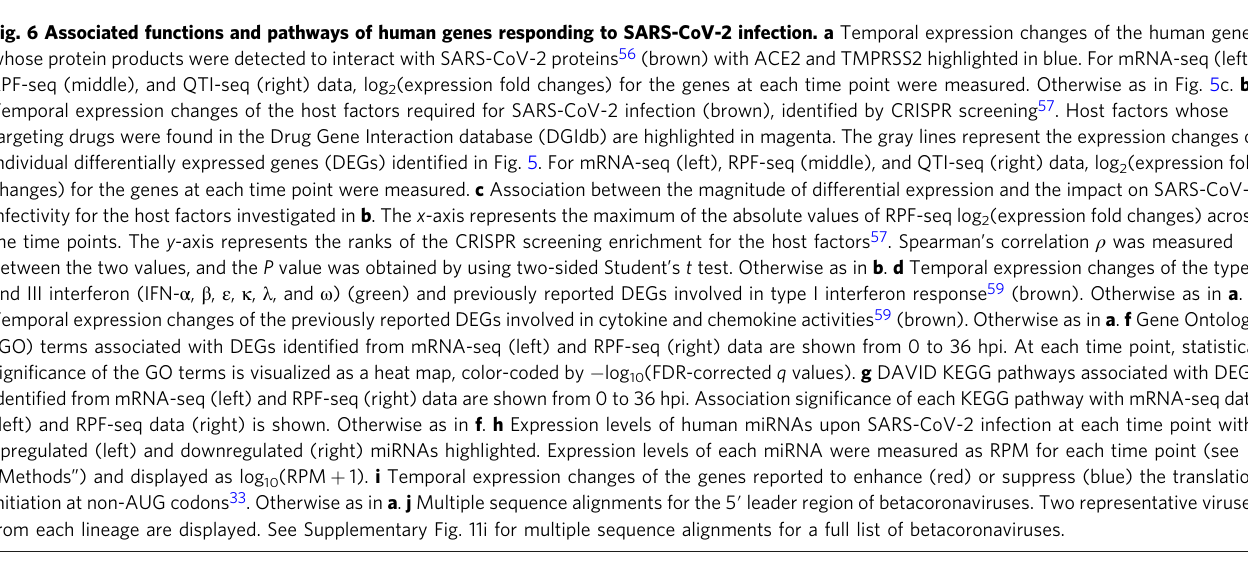
Fig. 6 Associated functions and pathways of human genes responding to SARS-CoV-2 infection. a Temporal expression changes of the human genes whose protein products were detected to interact with SARS-CoV-2 proteins 56 (brown) with ACE2 and TMPRSS2 highlighted in blue. For mRNA-seq (left), RPF-seq (middle), and QTI-seq (right) data, log 2 (expression fold changes) for the genes at each time point were measured. Otherwise as in Fig. 5c. b Temporal expression changes of the host factors required for SARS-CoV-2 infection (brown), identi fi ed by CRISPR screening 57 . Host factors whose targeting drugs were found in the Drug Gene Interaction database (DGIdb) are highlighted in magenta. The gray lines represent the expression changes of individual differentially expressed genes (DEGs) identi fi ed in Fig. 5. For mRNA-seq (left), RPF-seq (middle), and QTI-seq (right) data, log 2 (expression fold changes) for the genes at each time point were measured. c Association between the magnitude of differential expression and the impact on SARS-CoV-2 infectivity for the host factors investigated in b . The x -axis represents the maximum of the absolute values of RPF-seq log 2 (expression fold changes) across the time points. The y -axis represents the ranks of the CRISPR screening enrichment for the host factors 57 . Spearman ’ s correlation ρ was measured between the two values, and the P value was obtained by using two-sided Student ’ s t test. Otherwise as in b . d Temporal expression changes of the type I